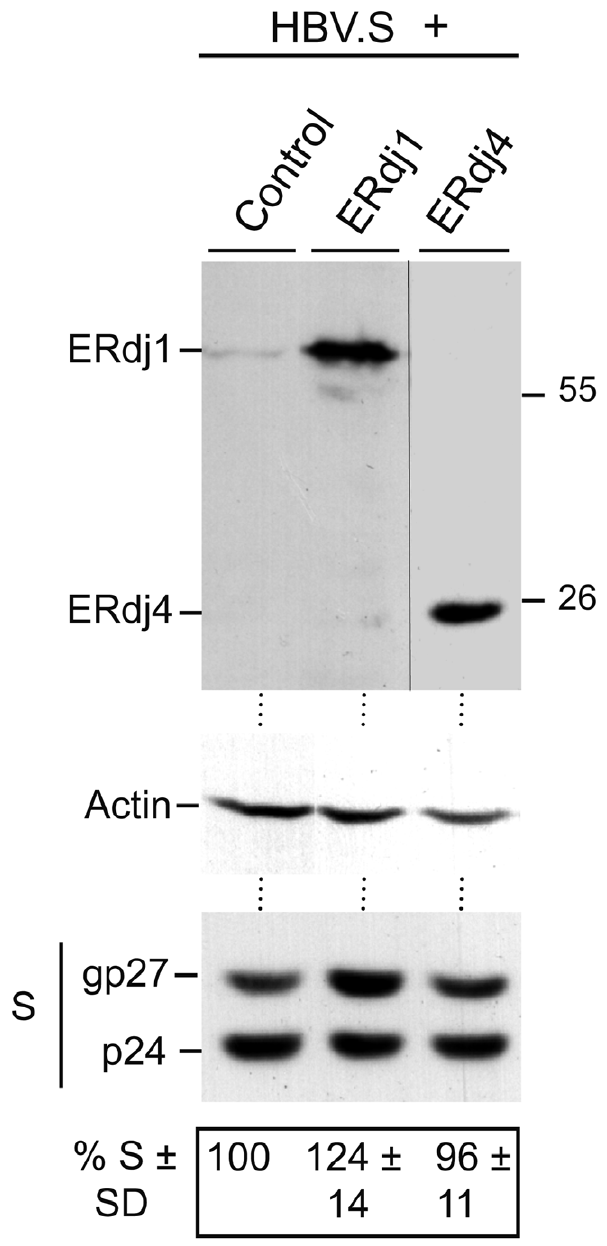
Figure 9. Overexpressing of ERdj1 and ERdj4 does not affect the steady-state HBV.S level. HBV.S was cotransfected with control DNA or FLAG-tagged ERdj1 and ERdj4 at a 1:3 DNA ratio, respectively, into HuH-7 cells. After transient expression for three days, lysates were prepared and assayed by WB using anti-FLAG (top), anti- b -actin (middle), or anti-HA antibodies (bottom). Relative HBV.S expression values 6 SD ( n =3) were determined as in Fig. 1. doi:10.1371/journal.pone.0049243.g009 individual functions of mammalian Sec62 and Sec63 proteins, as Sec63 was found in transient proximity to newly synthesized membrane proteins at early stages of membrane integration, while Sec62 was detected at a later stage [18]. Consistent with this, we show that the overexpression of Sec62 did not limit HBV.S